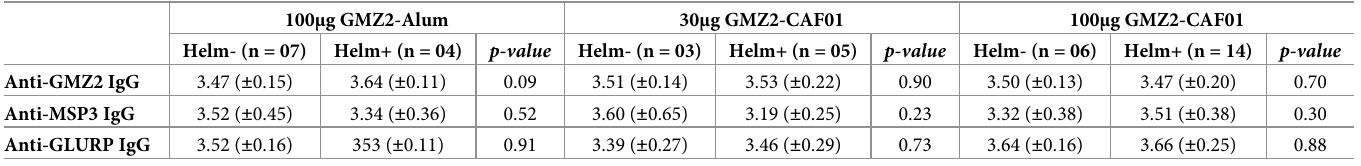
Table 2. Comparison of antibody log concentrations mean ( ± SD) between helminth infection groups at D84 stratified by study vaccination groups.